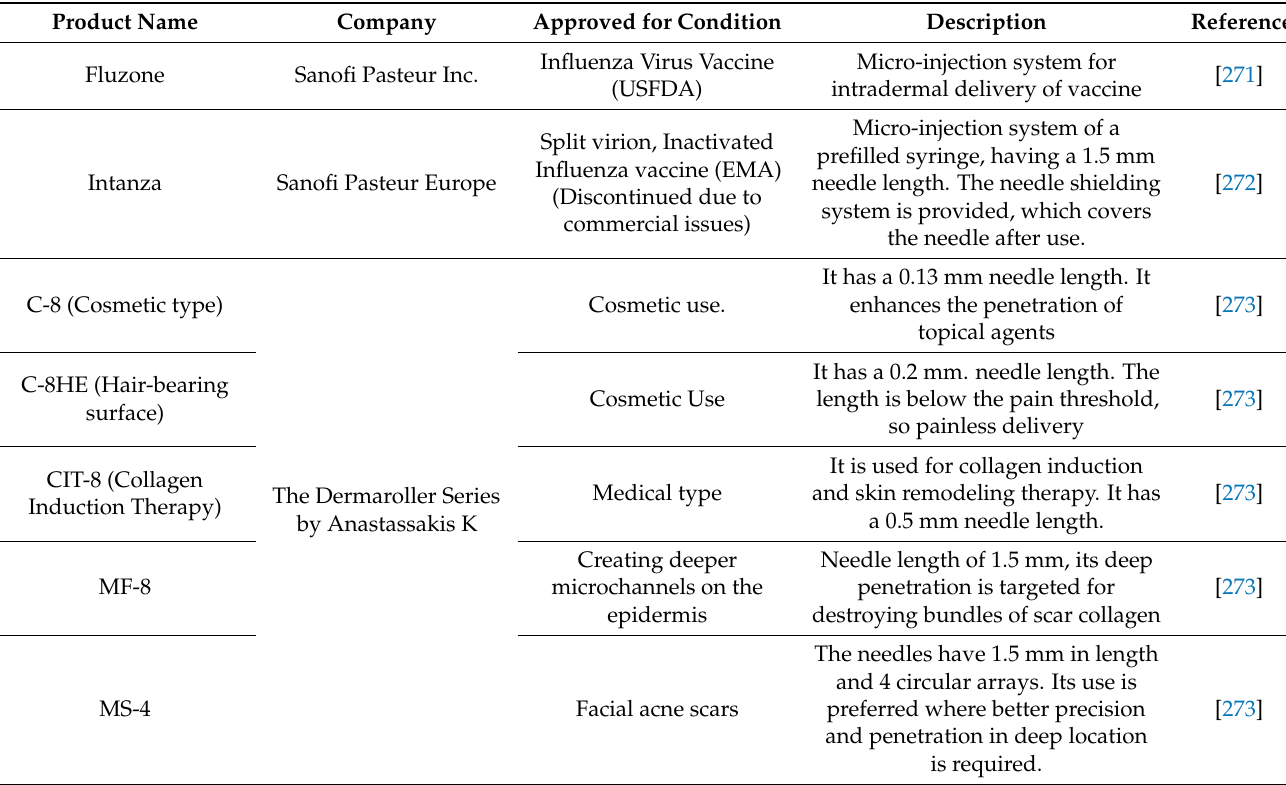
Table 3. Marketed product for